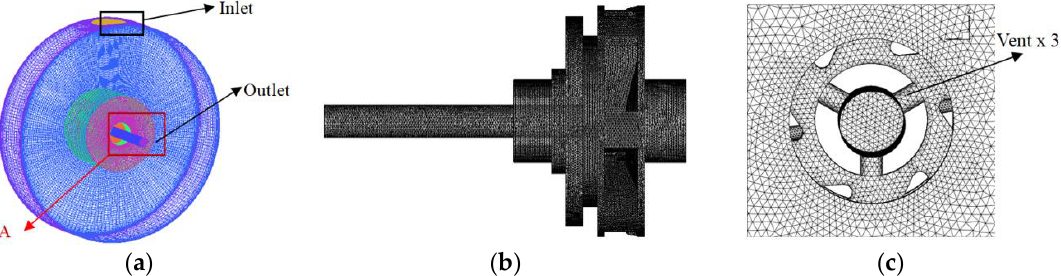
Figure 4. Physical models. ( a ) Whole computing domain; ( b ) local encryption of vent and hollow shaft; ( c ) partial structure.